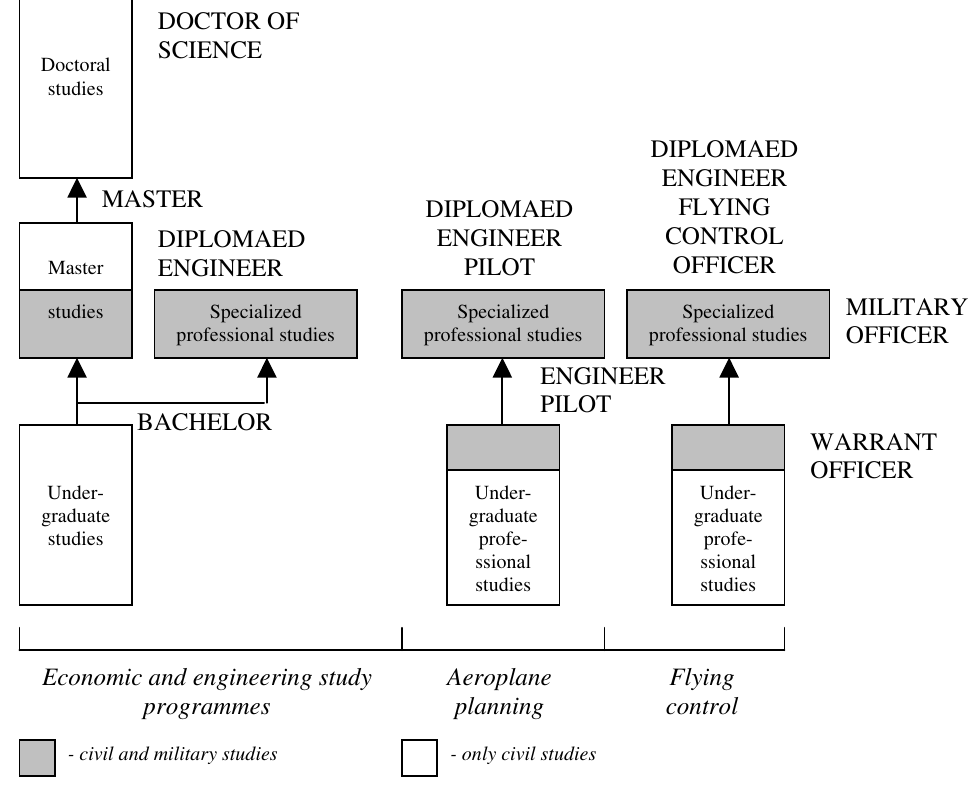
Fig 3. Study models for the training of aviation